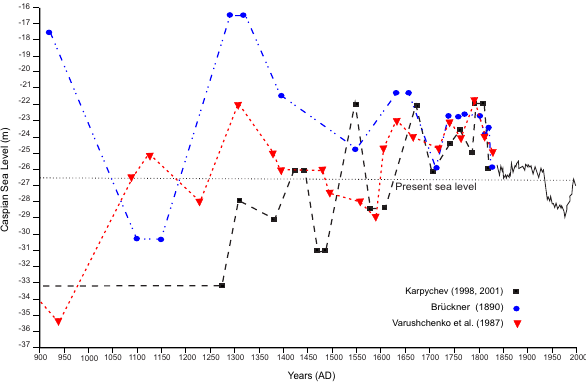
Fig. 6. The Caspian sea-level curve based on Br¨uckner (1890), Varushchenko et al. (1987) and Karpychev (1998, 2001). The dashed lines connecting the filled symbols are interpolations. The continuous line from 1850 to 2000 shows the instrumental obser- vations. A − 26.5 line, the CSL in 1995, was added as a reference level to compare the different levels over the past millennium. The Medieval Climate Anomaly (MCA) and the Little Ice Age (LIA) are indicated by shaded